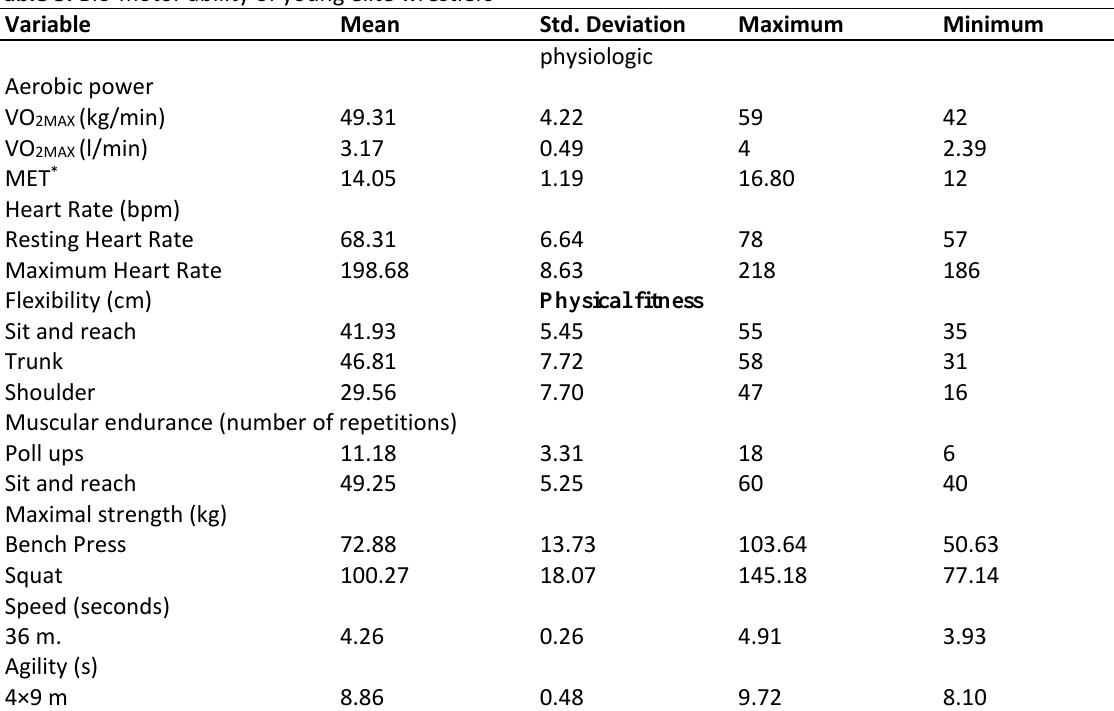
Table 3. Bio-motor ability of young elite